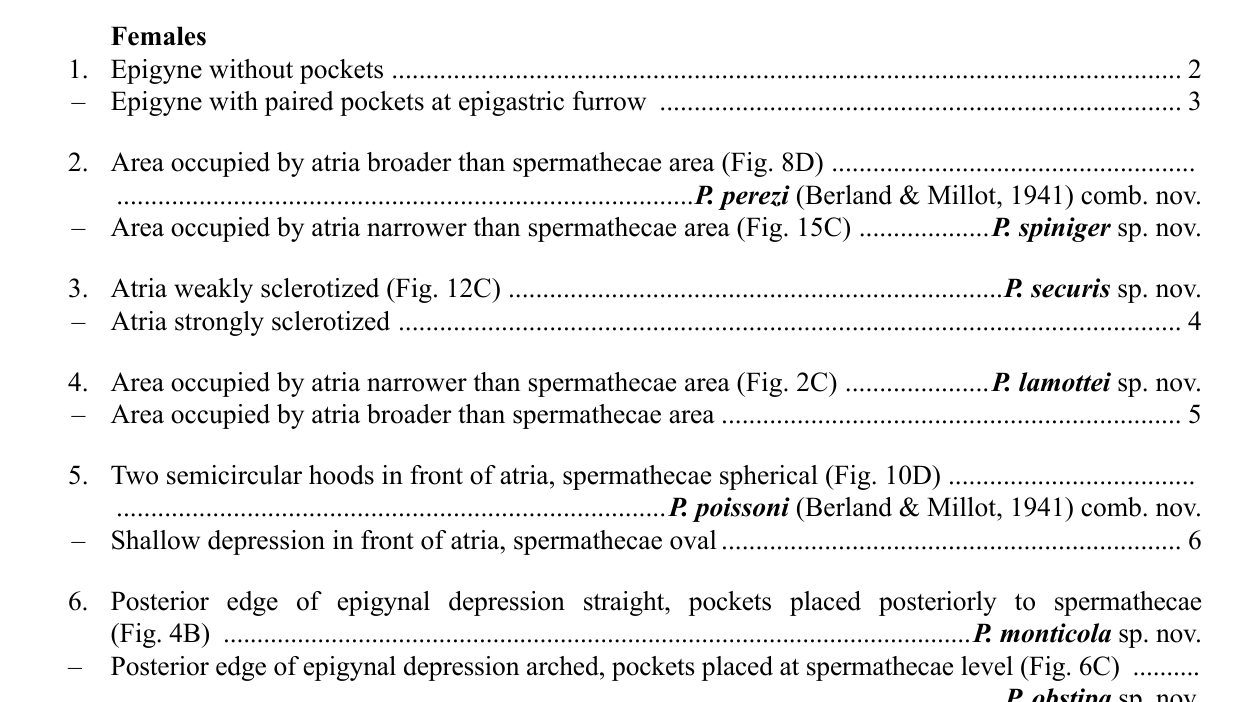
Posterior edge of epigynal depression arched, pockets placed at spermathecae level (Fig. 6C)